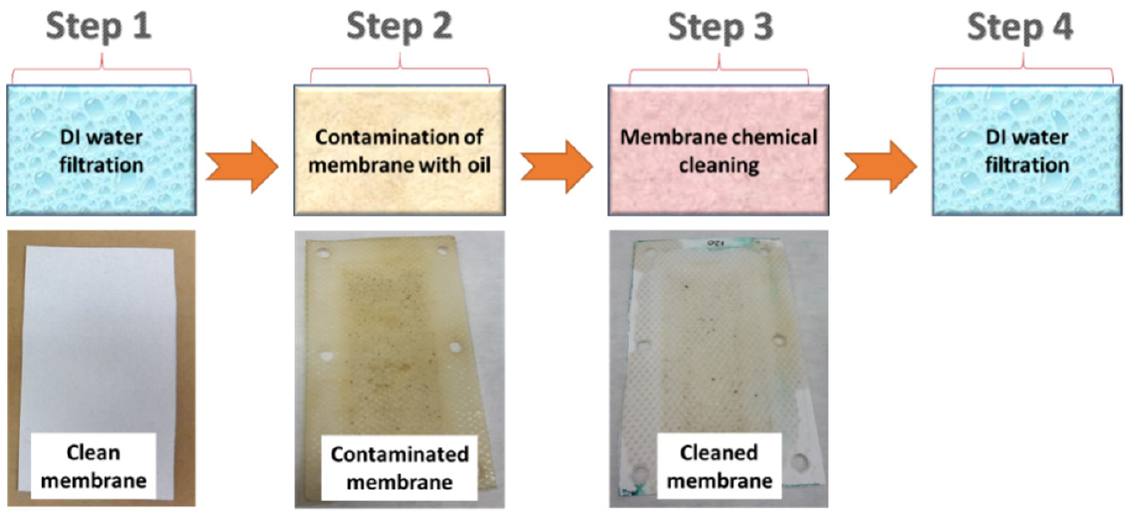
Figure 1. Stage 2 (the membrane chemical cleaning process). Membrane permeability ( P ) and flux recovery rate ( FRR ) were evaluated using Equa- tions (1) and (2):